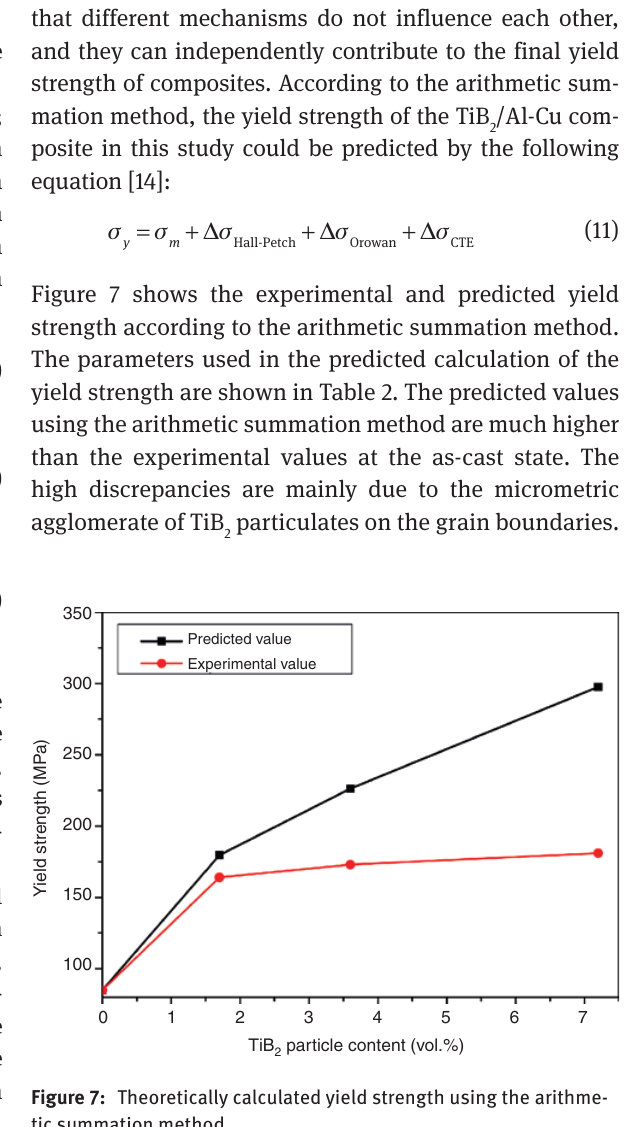
Figure 6: Effect of TiB properties.